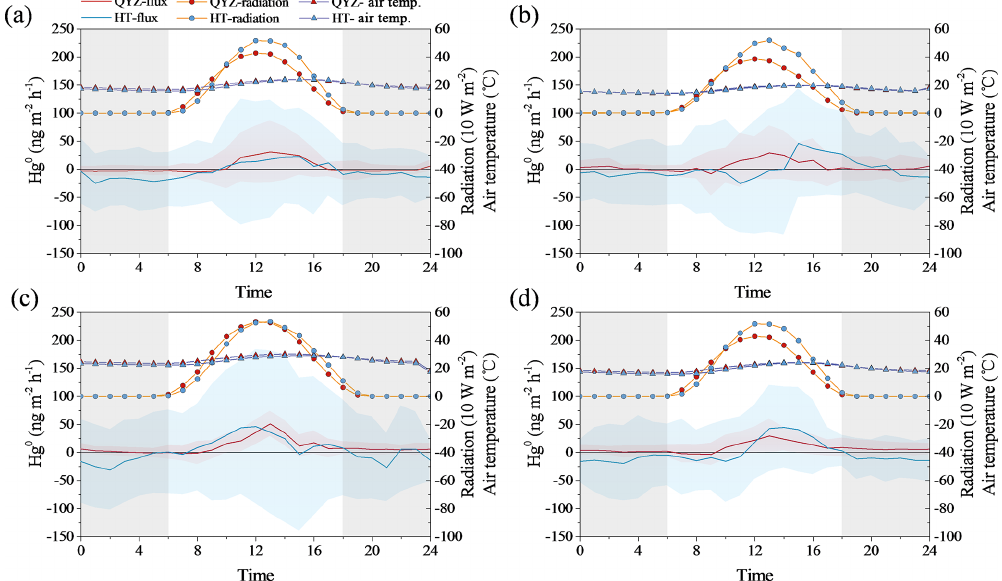
Figure 4. Diurnal variation in GEM fluxes, air temperature and solar radiation over forest canopy in each season. (a) Winter: December to February; (b) spring: March to May; (c) summer: June to August; (d) fall: September to October. Lines and envelopes depict mean values and standard variances. Diurnal variation in GEM gradient and turbulent transfer coefficient ( K ) in each season at two sites is presented in Fig. S2.